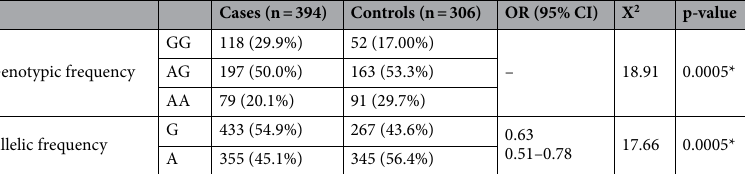
Table 3. Genotypic and allelic frequency of CYP19 gene in PCOS as compared with control women. Data is presented as number (%) of PCOS and controls. GG, AG and AA are genotypes in PCOS and controls, PCOS polycystic ovary syndrome, G and A are alleles for polymorphism, OR Odds Ratio, CI confidence interval, χ 2 chi-square test. *Significant p value < 0.05.